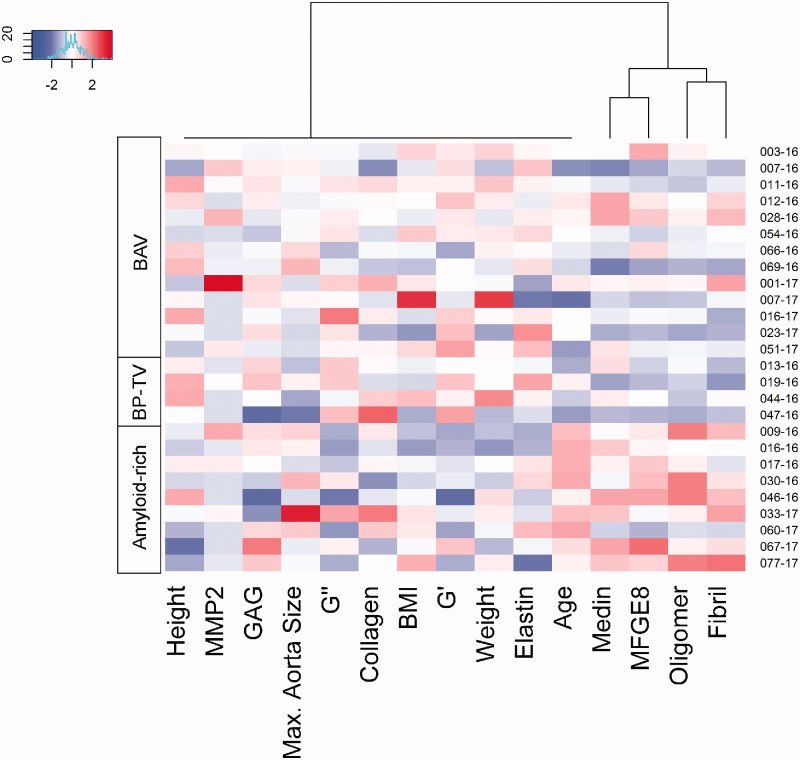
Heatmap of all patients. In rows are shown the patients grouped by their identity as shown. It is noticeable that bicuspid like phenotype-tricuspid valve (BP-TV) share more similarities with bicuspid valve (BAV) patients that amyloid-rich particularly in amyloid characteristics (bottom right corner); medin, MFGE8, oligomer, fibril levels and age. Data was mean centred and scaled. Colours represent lower abundance than the mean (blue), close to the mean (white) and higher abundance than the mean (red). Variables are ordered based on complete-linkage clustering for easy visualisation.